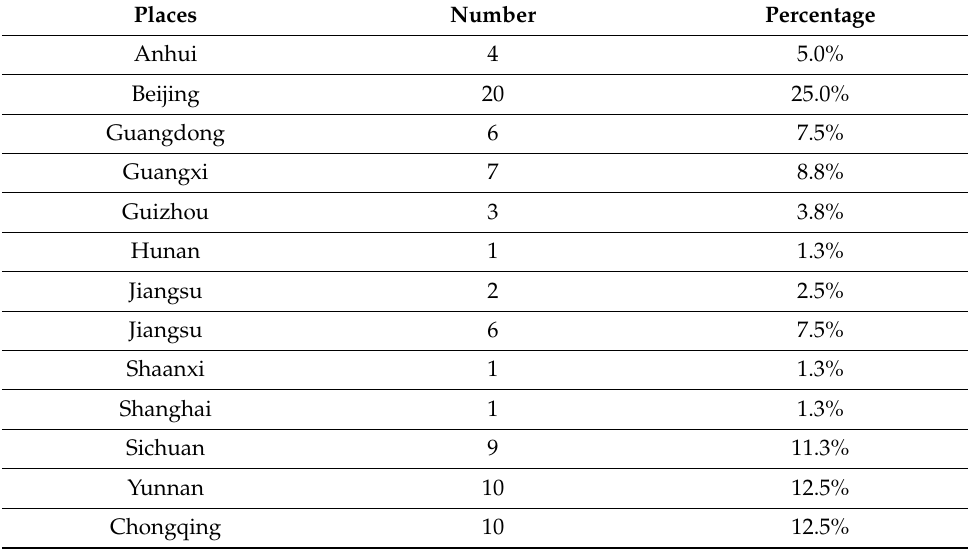
Table 1. Spatial distribution of Artist Village